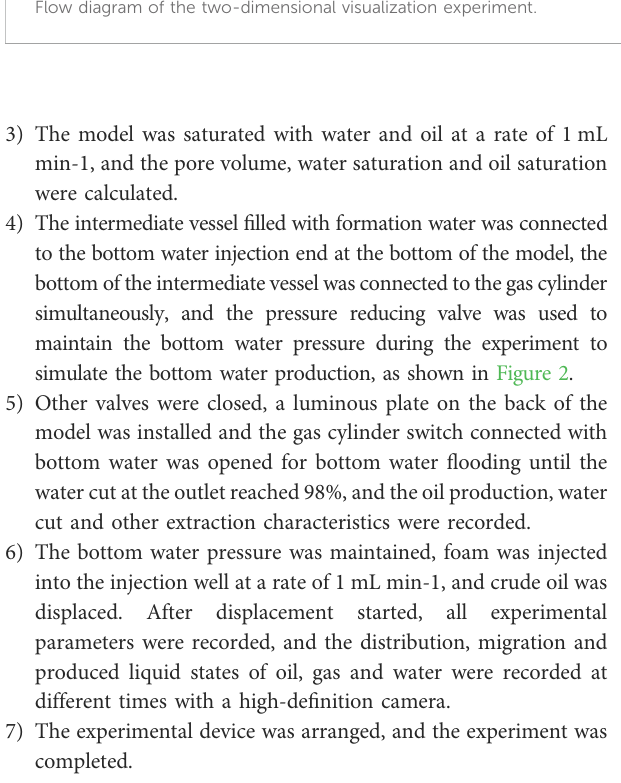
FIGURE 2 Flow diagram of the two-dimensional visualization experiment.